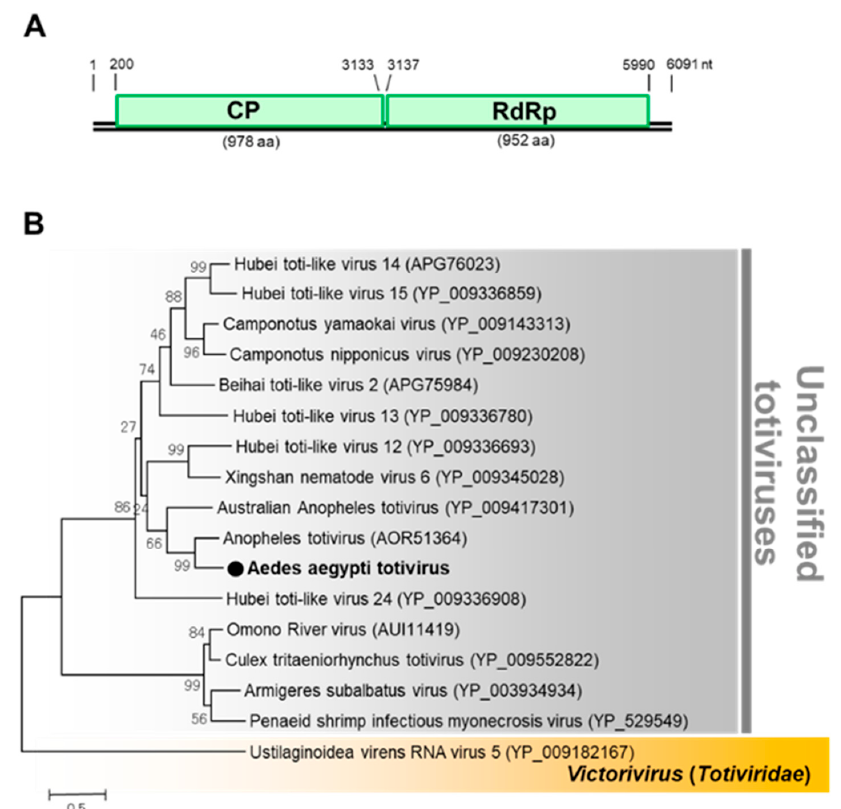
Figure 13. Genomic characterization of Aedes aegypti totivirus (AaTV). ( A ) Genome organization of AaTV. ( B ) Phylogenetic analysis of AaTV. Maximum likelihood tree of AaTV constructed with the conserved amino acid domain of the genome sequence with Genbank accession number LC496074. The conserved domains were extracted using MAFFT 7 online version [27] and the Gblocks program [28]. Bootstrap support values from 1000 bootstrap replicates are indicated on the branches.